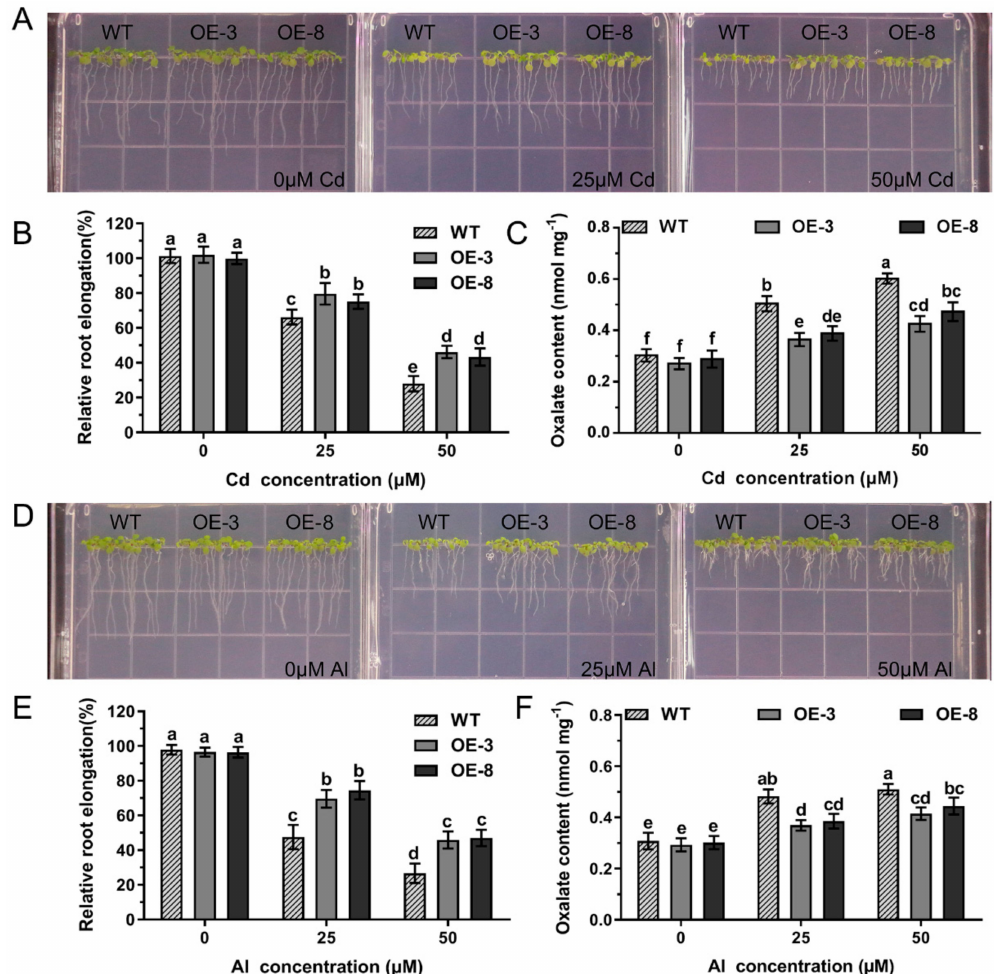
Figure 6. Overexpression of GsAAE3 in A. thaliana . ( A , D ) Cd and Al tolerances phenotypes of overexpressing GsAAE3 in transgenic A. thaliana lines. ( B , E ) Statistical analysis of relative root elongation. ( C , F ) The e ff ect of Cd and Al stresses on oxalate content in wild-type and transgenic A. thaliana lines. Four days after vernalization, the T 3 transgenic seeds (OE3 and OE8) and the wild-type (columbia-0) were cultivated on the Cd concentration gradients agar medium added with 0, 25, and 50 µ M CdCl 2 or Al concentration gradients agar medium added with 0, 25, and 50 µ M AlCl 3 . After 7 days in culture, the images of the phenotypes of the GsAAE3 transgenic lines were recorded for statistical analysis. The root elongation was measured using Image J software ( n = 3). After treatment, the roots of A. thaliana were ground into fine powder with liquid nitrogen and then extracted with distilled water for oxalate content analysis ( n = 3). All data are presented as means ± SD. Di ff erent letters indicate statistically significant di ff erence, using one-way ANOVA and Duncan’s test ( p ≤